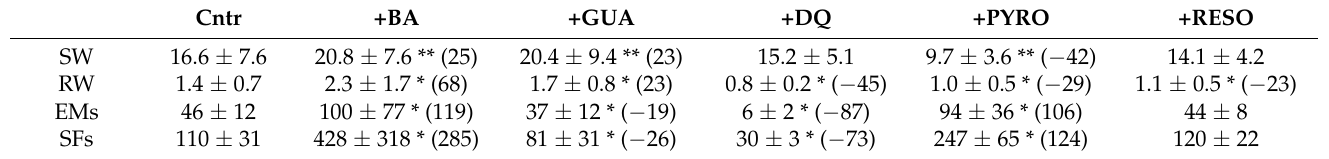
Table 6. Plant growth and infection factors detected 40 days after inoculation with RKN J2s (100 J2/plant), in tomato plants untreated (cntr) and treated with benzoic acid (BA 2.0 mg/g pfw), guaiacol (GUA 5 mg/g pfw), duroquinone (DQ 2.5 mg/g pfw), pyrogallol (PYRO, 3 mg/g pfw), and resorcinol (RESO, 5 mg/g pfw) by soil drench 1 day before inoculation. Plant growth was assessed by shoot (SW) and root weights (RW) expressed in grams; nematode infection severity is indicated by egg masses (EMs) per root system and sedentary forms (SFs) per root system. Mean values ± standard deviations obtained from untreated and AC-treated tomato plants were differentiated by a paired t -test (* p < 0.05; ** p < 0.01). In parentheses, significant differences are expressed as percentages. +BA +GUA